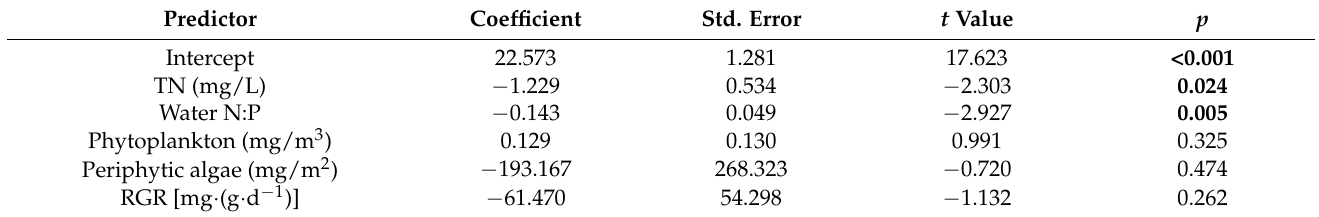
Table 2. Summary of the best model of the relationship between H. verticillata C:N and water N:P.